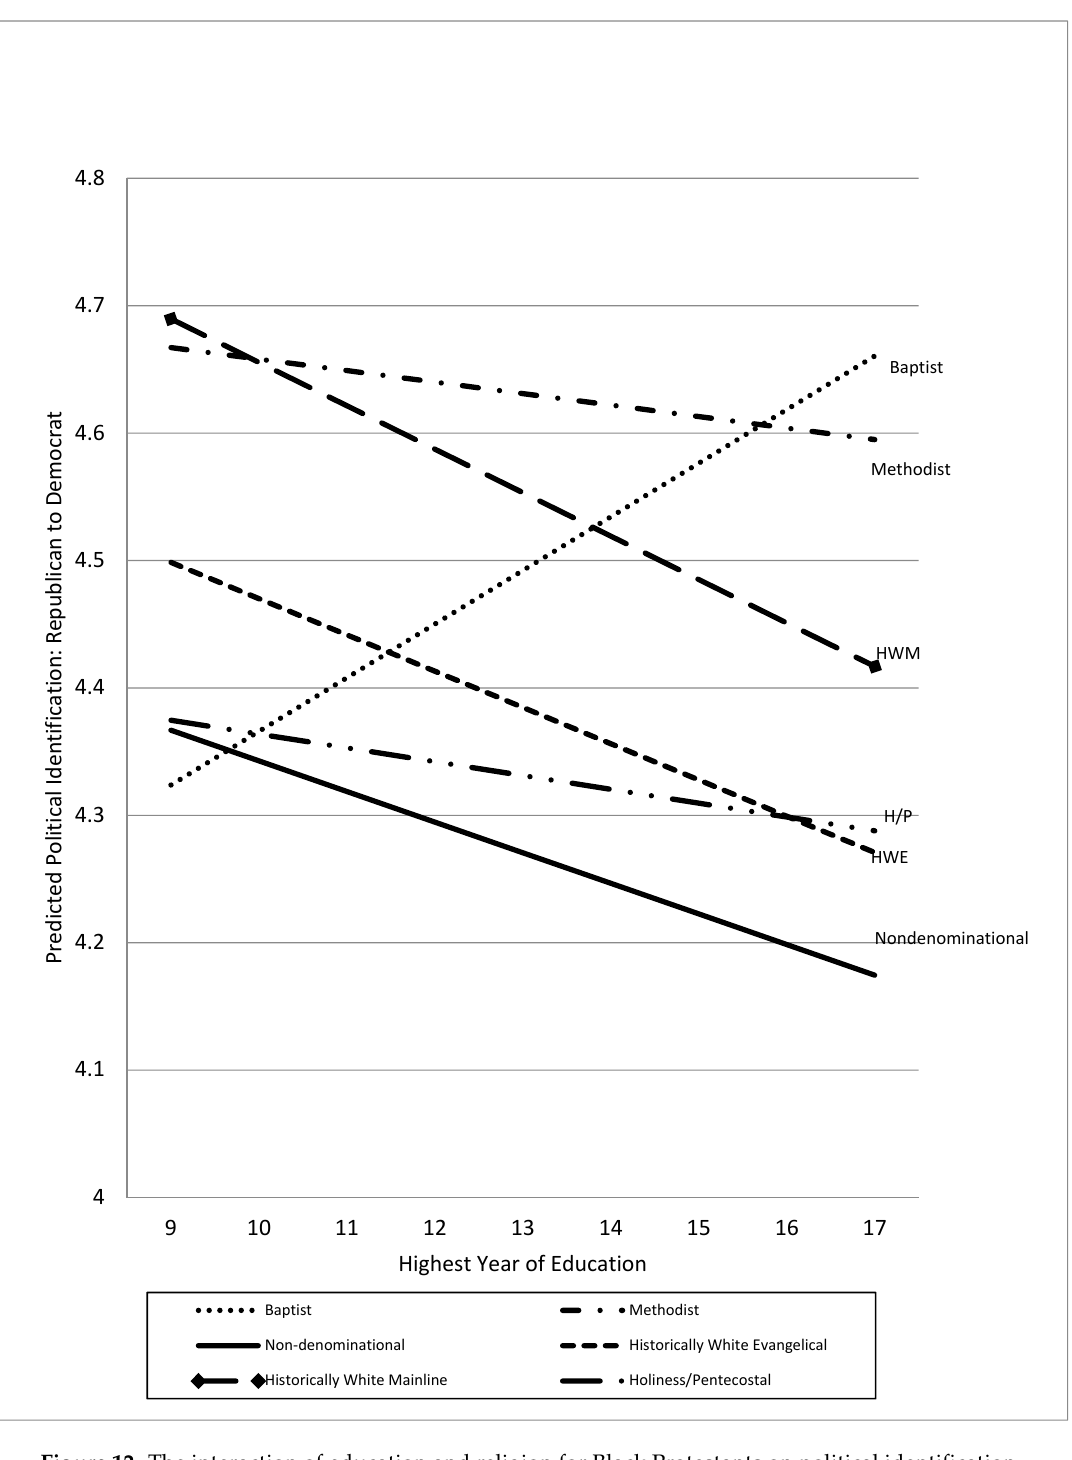
Figure 12. The interaction of education and religion for Black Protestants on political identification.